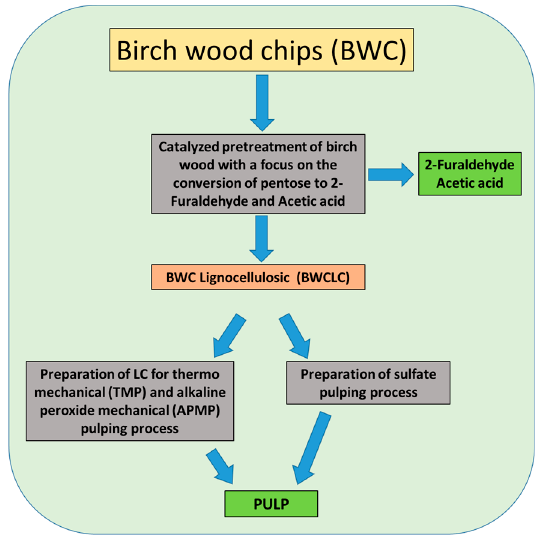
Figure 1. Basic flow diagram of the new process.